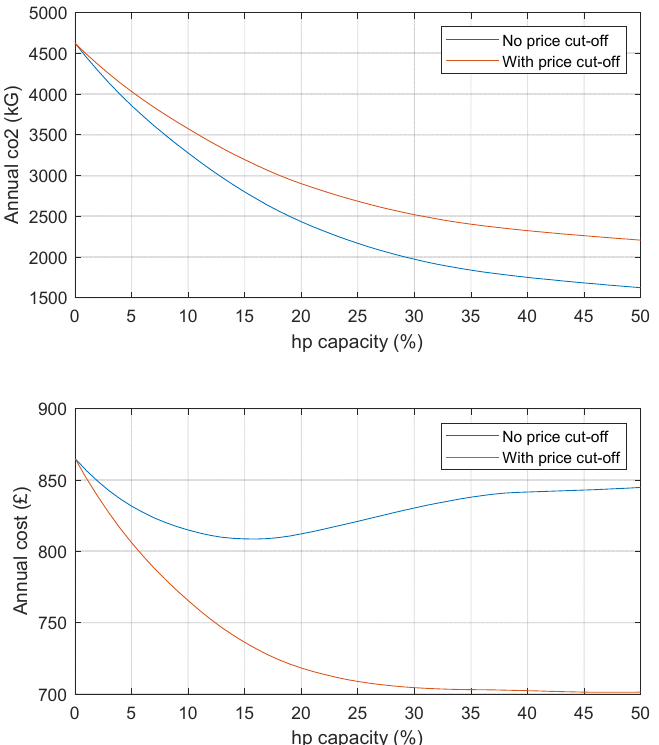
Figure 9. CoCo hybrid annual fuel costs and CO 2 emissions, based on varying emissions factors (actual emissions data) and half-hourly varying prices (Octopus Agile), where HP does not come on when electricity price above £0.20/kWh, for OXF1.